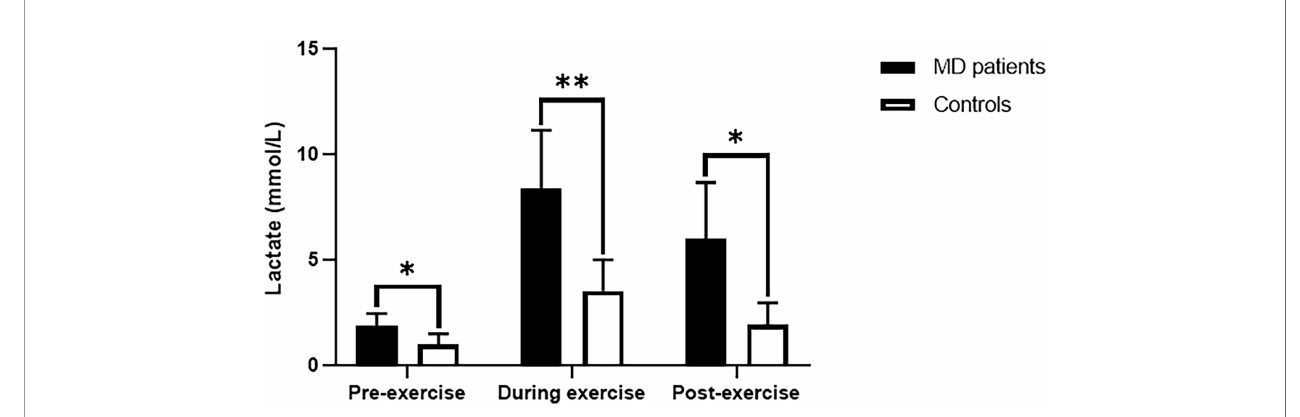
FIGURE 1 | Lactate values for exercise tests in MD patients and T1DM patients. MD, Mitochondrial diabetes; T1DM, Type 1 diabetes mellitus. *p < 0.05,**p <